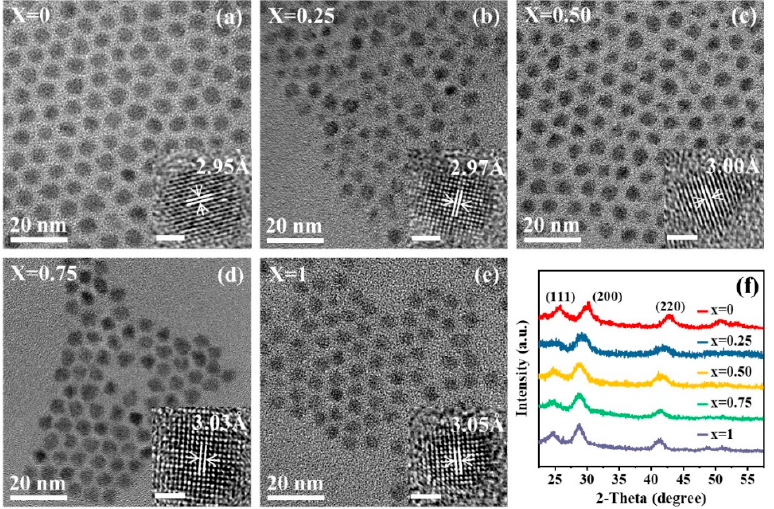
Figure 1. ( a – e ) TEM and HRTEM images (insert, scale bar: 2 nm) of PbS 1 − x Se x QDs. ( f ) XRD patterns of PbS 1 − x Se x QDs. of PbS 1 − x Se x